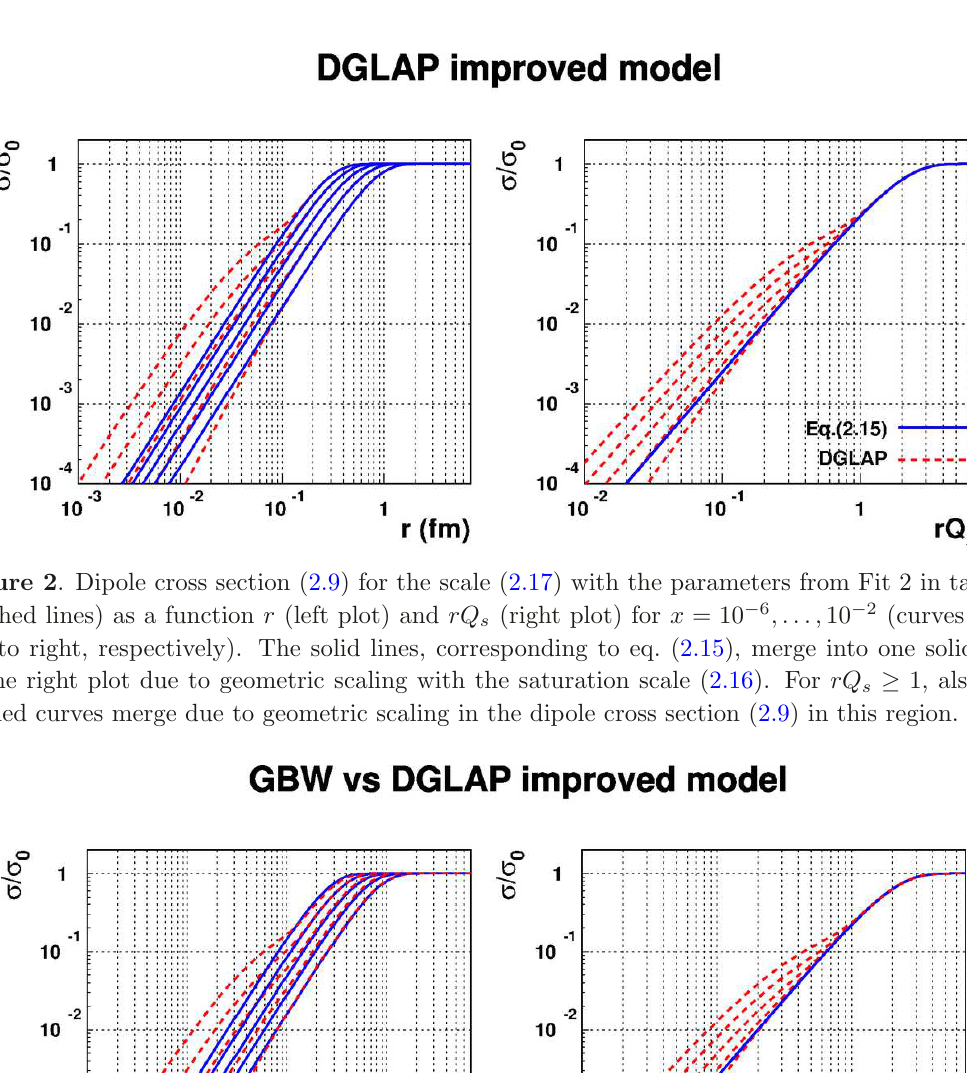
Figure 3 . The normalized-to-one dipole cross sections (2.6) (solid lines) and (2.9) (dashed lines) with the parameters from Fit 2 in table 1 and 3, respectively, for x = 10 − 6 , . . . , 10 − 2 (curves from left to right, respectively) Geometric scaling for the variable rQ s is clearly visible in the right